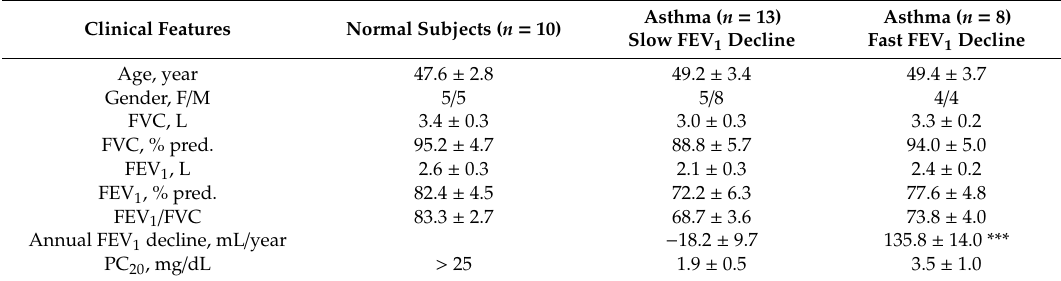
Table 1. Baseline characteristics of the normal subjects and asthmatics.